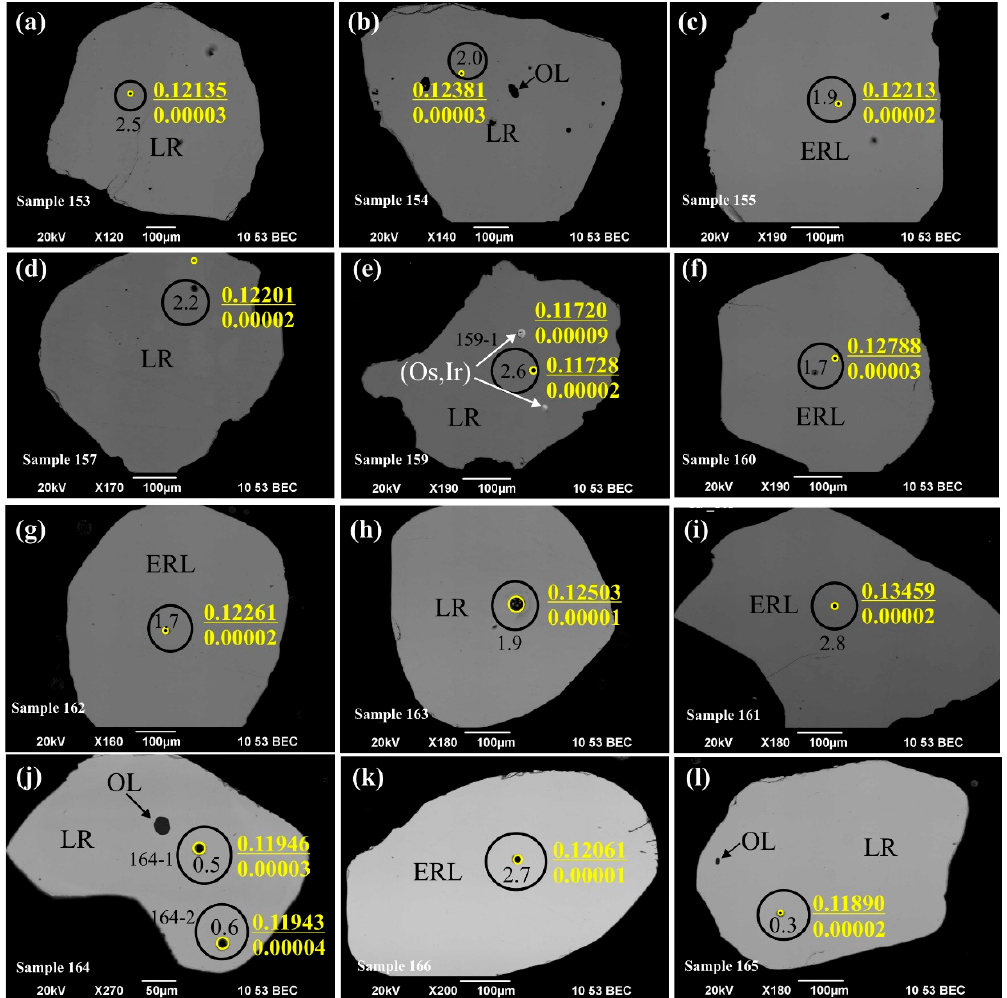
Figure 8. Back-scattered electron images of Ru-Os sulfides type 1 at Verkh-Neivinsk: ( a )—sample 153, ( b )—sample 154, ( c )—sample 155, ( d )—sample 157, ( e )—sample 159, ( f )—sample 160, ( g )—sample 162, ( h )—sample 163, ( i )—sample 161, ( j )—sample 164, ( k )—sample 166, ( l )—sample 165. Yellow circles with a diameter of 15–40 µm denote areas of Os-isotope analyses listed in Table 4. Yellow numerals in the numerator and denominator correspond to the 187 Os/ 188 Os value and the measurement error, respectively. Black circles with a diameter ca. 100 µm denote spots of S-isotope analyses listed in Table 4. The numbers correspond to the δ 34 S (‰) value. LR—laurite, ERL—erlichmanite, (Os, Ir)—iridian osmium, OL—high-Mg olivine.